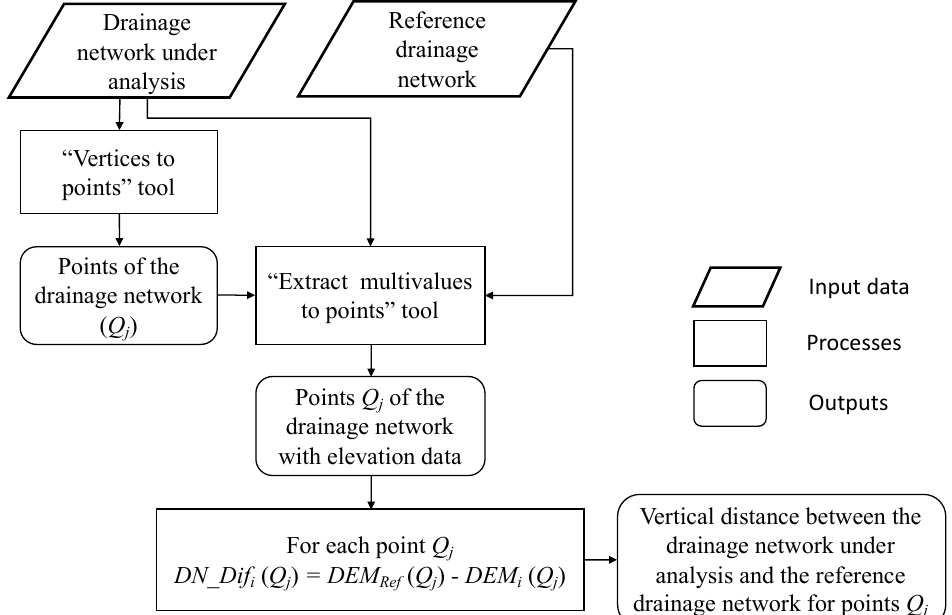
Figure 15. Flowchart of the procedure to assess the vertical accuracy of the drainage networks.